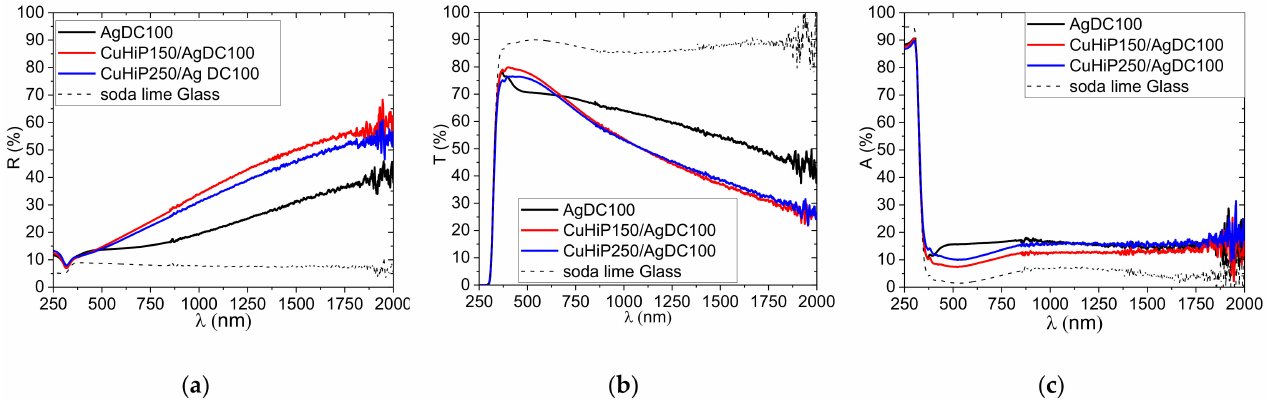
Figure 8. Reflectivity ( a ), transmission ( b ) and absorption ( c ) spectra of Ag DC100 monolayer compared with the bilayers including Cu HiP150 and CuHiP250.